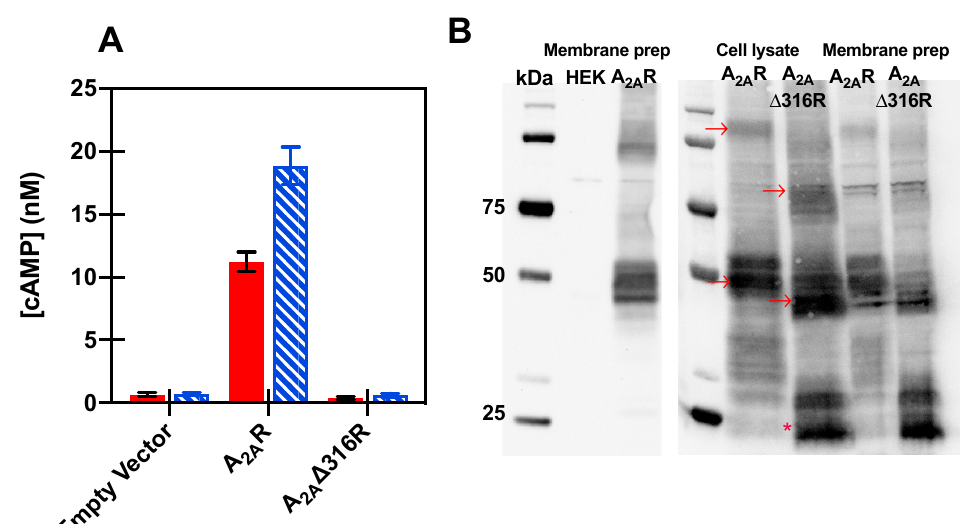
Figure 2. Transiently transfected HEK-293 cells were used to determine downstream signaling for chimeras. ( A ) Agonist-mediated cAMP accumulation for transiently transfected cells with A 2A R and A 2A ∆ 316R (DMSO only shown in red filled bars, 1 µ M CGS21680 agonist in blue hatched bars). Data represent mean ± S.E.M. for three independent transfections performed in triplicate (* p < 0.001, Student’s t -test). ( B ) Representative Western blot analysis of A 2A R and its truncation from transiently transfected in HEK-293, as obtained from equal protein loadings of total cell lysate or membrane fractions. HEK sample shows HEK-293 cells transfected with pCEP only compared to pCEP-A 2A R. Dimer and full-length monomeric receptor are indicated by arrows in cell lysates, and multiple forms visible—particular in the monomeric form at ~50 kDa—can be attributed to variable glycosylation. Samples of A 2A ∆ 316R shows a smaller band visible at ~30 kDa that is likely a proteolytic product, indicated by an asterisk. Expected molecular weights for A 2A R is 44.7 kDa and A 2A ∆ 316R is 35.1 kDa, and molecular weights were determined using Precision Plus Protein Western C standards.